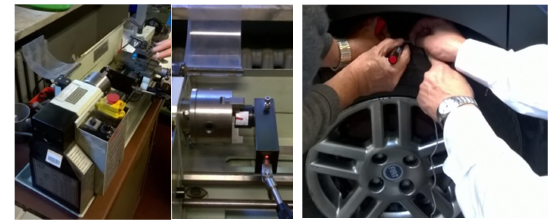
Figure 5. On the left: the DMI during calibration; on the right: